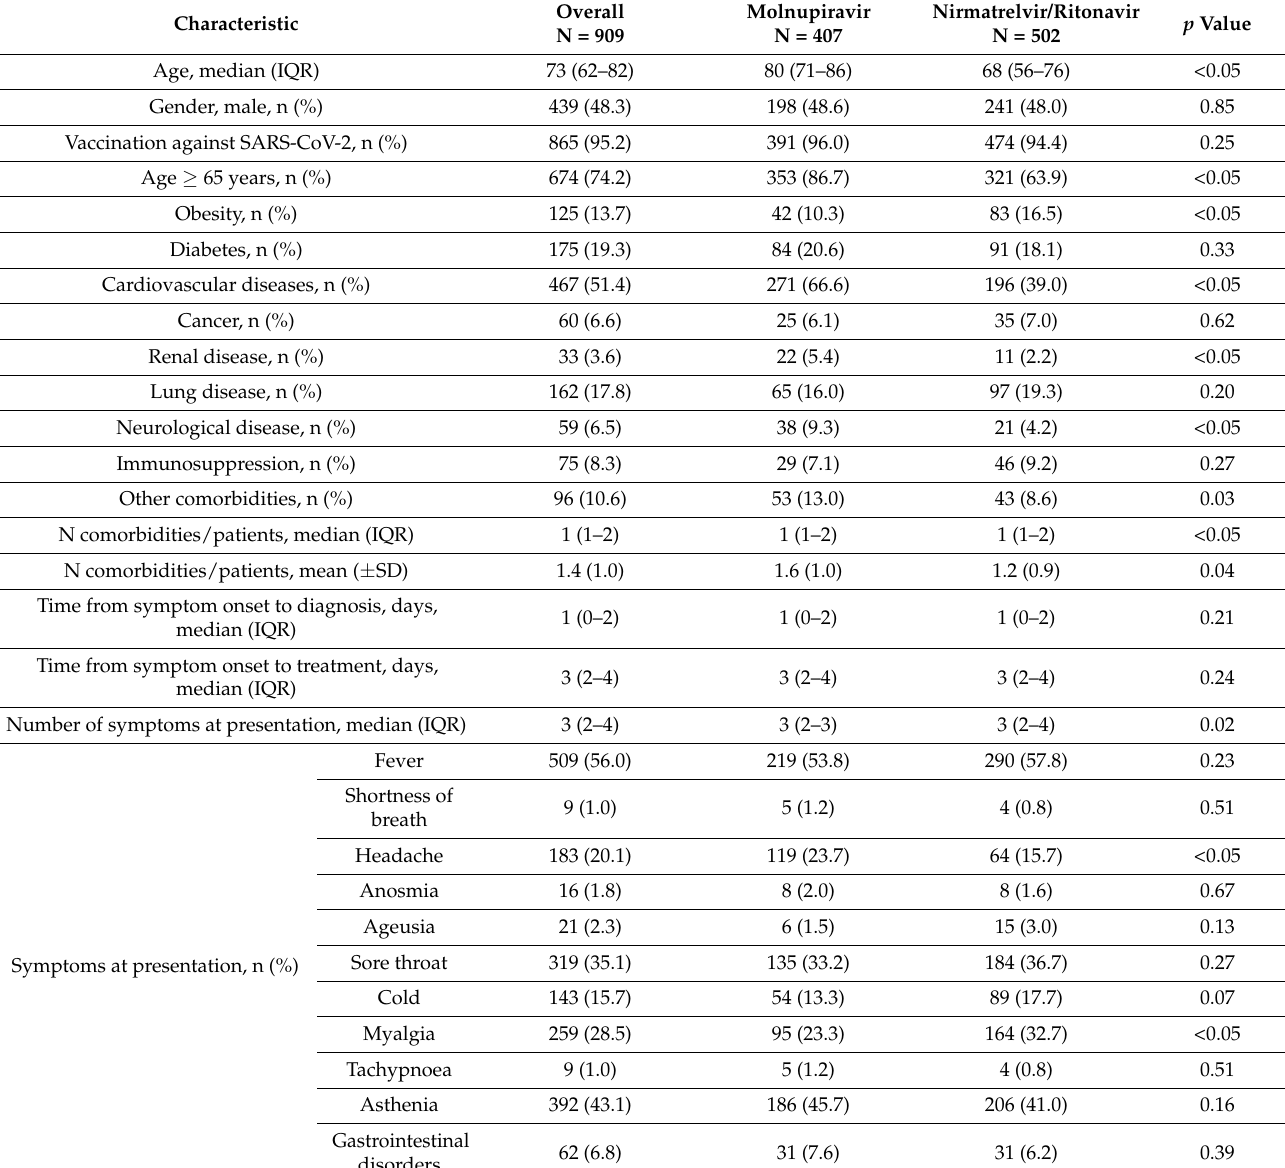
Table 1. Baseline characteristics of the study